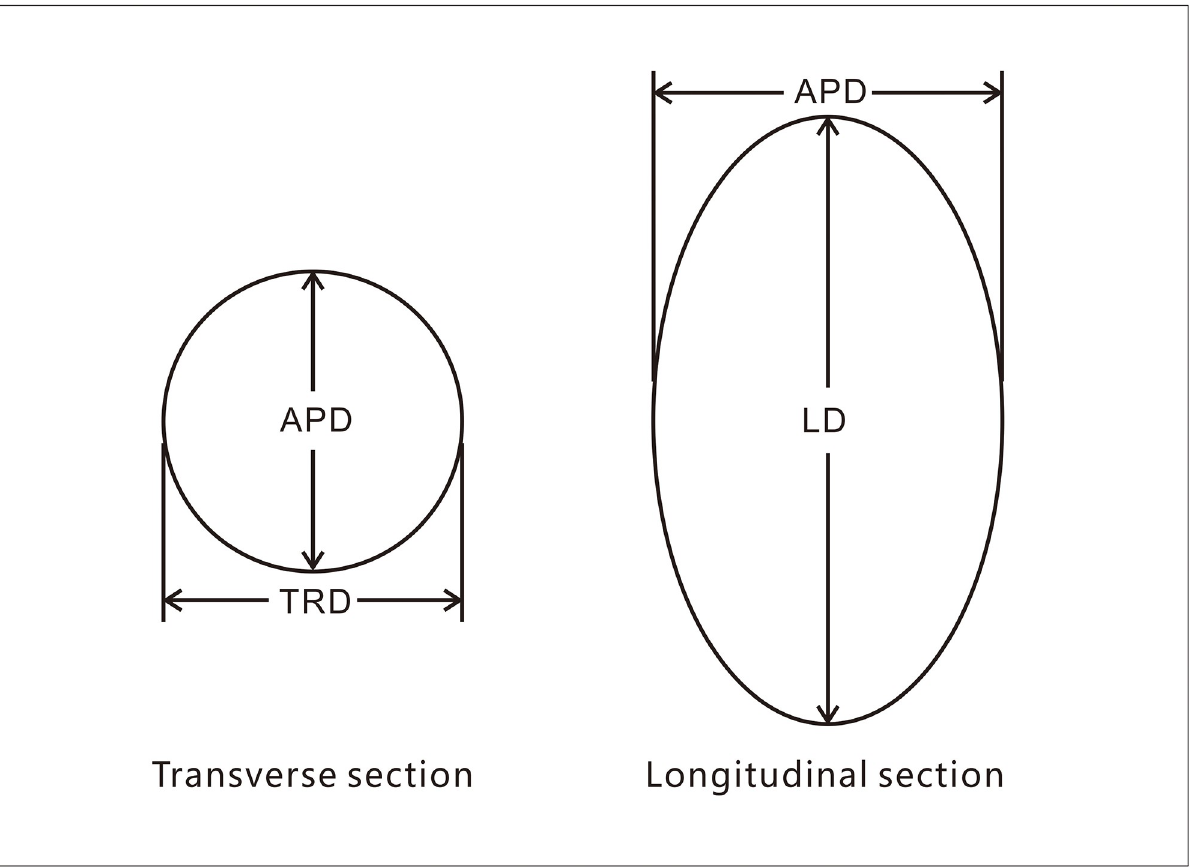
Fig 2. The TRD, APD, and LD were measured in the transverse and longitudinal